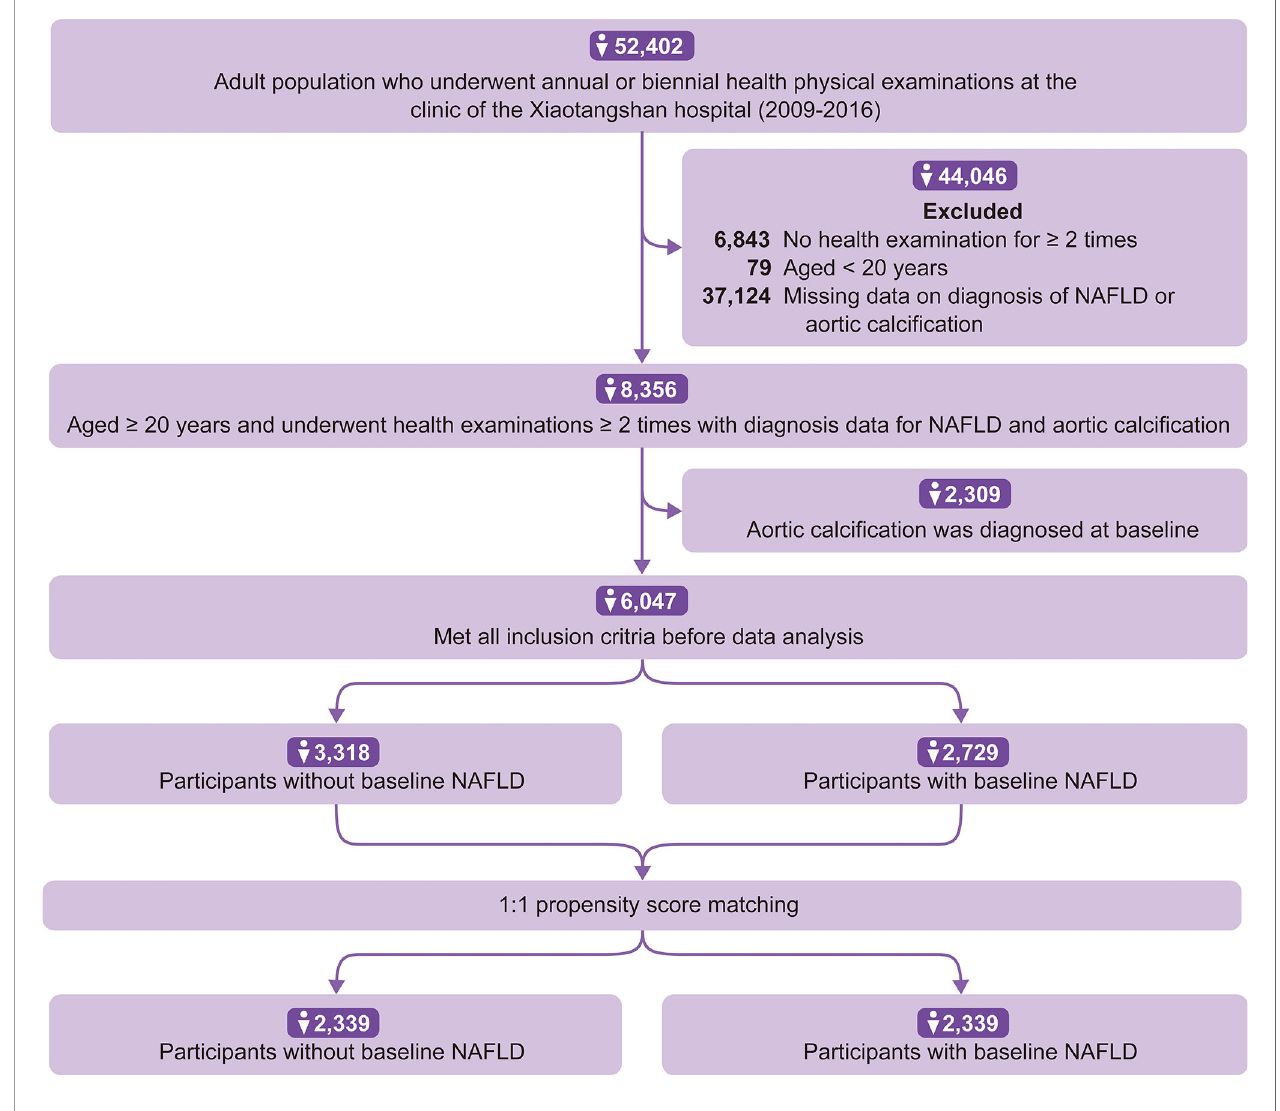
FIGURE 1 | Flow chart of study participants